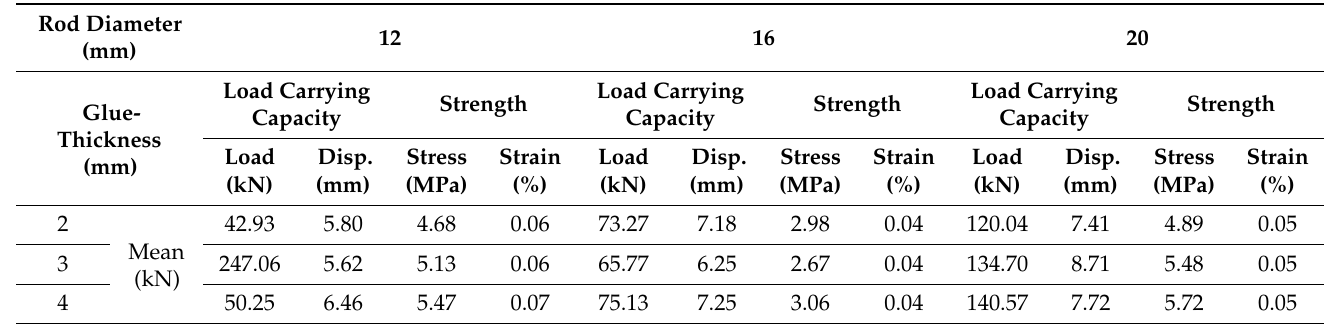
Table 6. GRPS90 ◦ of Glued-In Perpendicular to Grain Direction for Rod 12 mm, 16 mm and 20 mm Diameter.